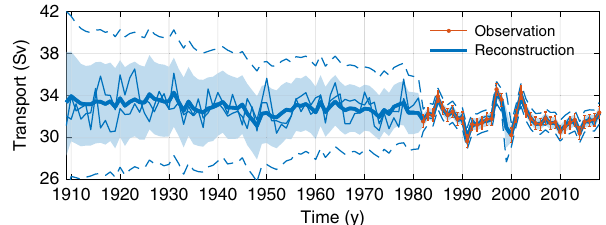
Fig. 2 Florida Current transport. Blue shows posterior median (thick line), 95% pointwise (light shading), and pathwise (dash dot) credible intervals, along with two arbitrary, randomly selected ensemble members (thin lines) from the probabilistic Florida Current transport solution. Orange shows annual transport from raw submarine-cable-data plus and minus twice the standard error estimated following refs. 3,4 .